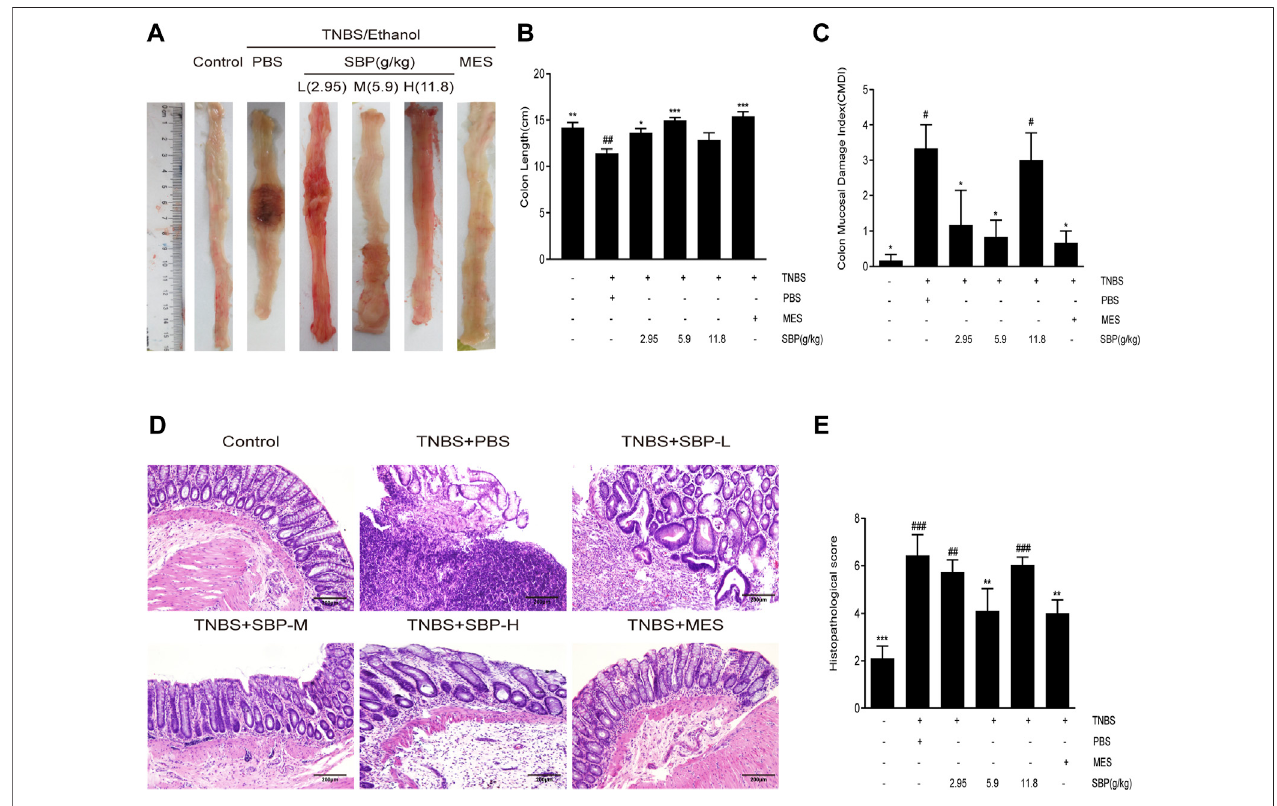
FIGURE 2 | SBP on the histopathology . (A) Representative macroscopic colon tissue. (B) Colon length of each group. (C) Colon mucosal damage index (CMDI). (D) Histopathological pictures of the colon tissue using H&E staining. Scale bar = 200 µM. (E) Histopathological scores for colon. Data shown as means ± SEM, n = 6 rats/group. vs. TNBS + PBS group, * p < 0.05, ** p < 0.01. vs. Control group, # p < 0.05, ## p < 0.01, ### p <